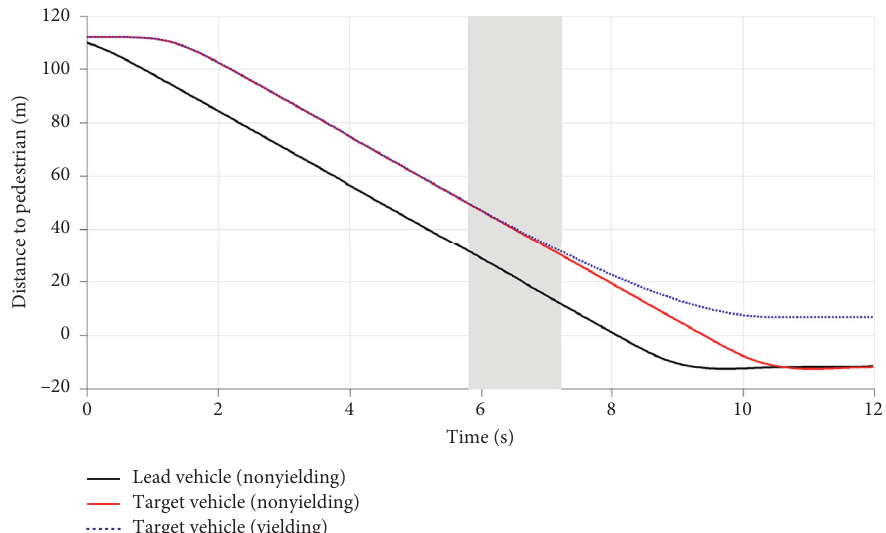
Figure 2: The approaching vehicles’ distance to pedestrian (distance measured parallel to the road) in the Baseline and eHMI conditions. Vehicles approached from around a corner at about 115m distance and turned left at a corner after passing the participant (pedestrian distance 12m. The grey area represents the region where the AV could detect hand gestures in the Hand and Combination conditions (i.e., distance to pedestrian between 30 and